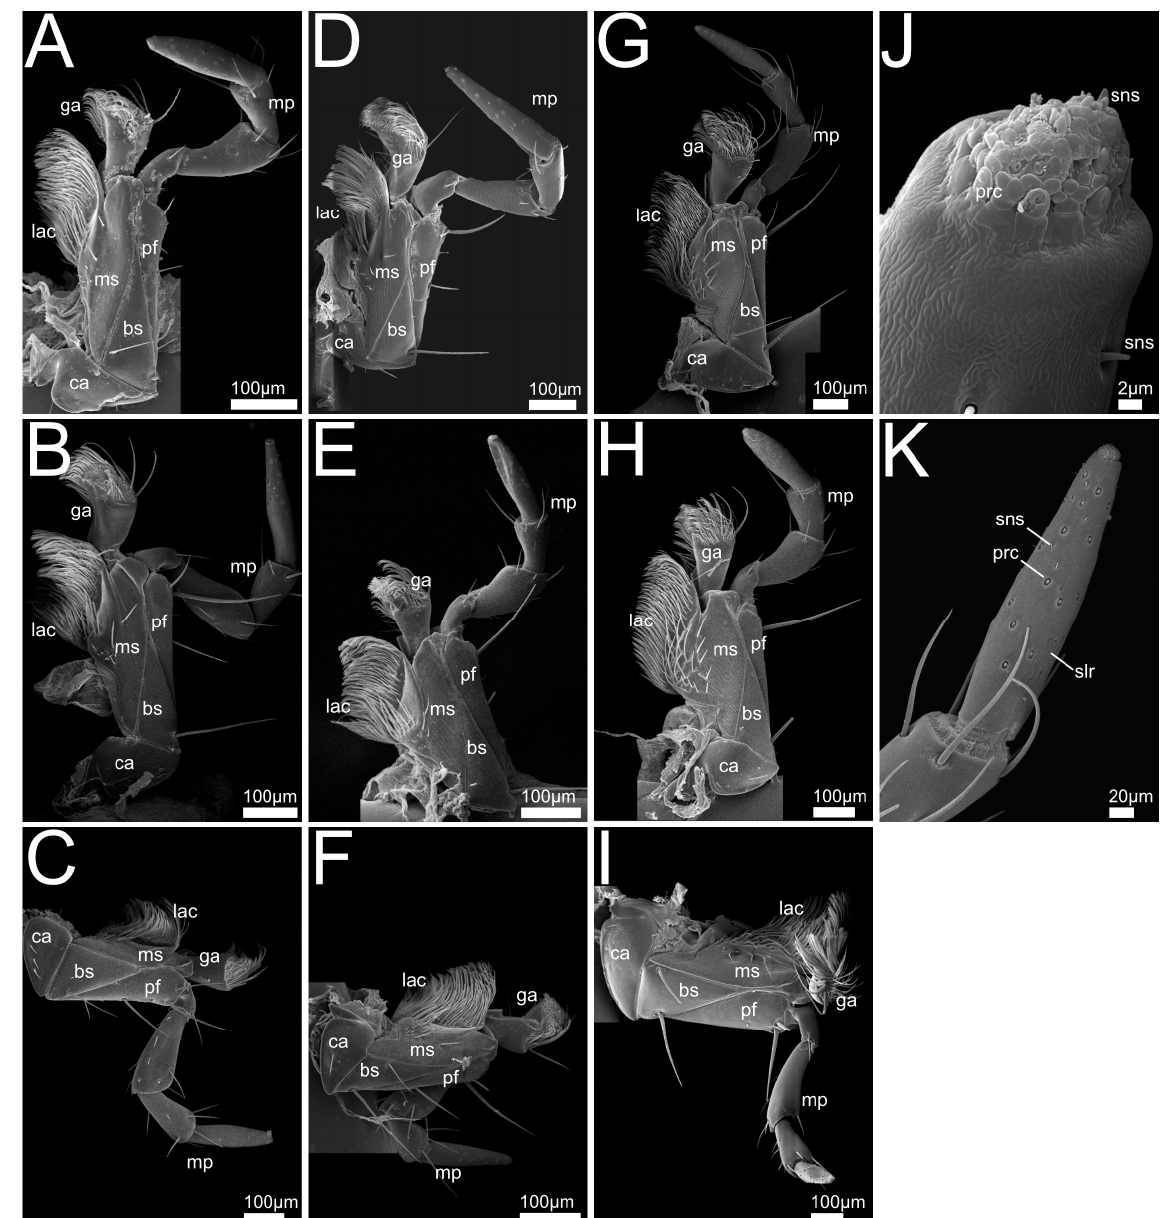
Figure 10. SEM views of Staphylinini maxilla. Images A – I ventral aspect of maxilla J – K with detailed views of apical palpomeres and receptors. ( A ) Bisnius sordidus ; ( B ) Philonthus varians ; ( C ) P. marginatus ; ( D ) P. rufipes ; ( E ) P. discoideus , ( F ) P. alpinus ; ( G ) Quedius cinctus ; ( H ) Q. cruentus ; ( I ) Q. curtipennis ; ( J ) B. sordidus , apical receptor bundle; ( K ) Q. cinctus , apical segment of maxillary palp. Abbreviations: bs: basistipes; ca: cardo; ga: galea; lac: lacinia; ms: mediostipes; mp: maxillary palp; pf: palpifer; prc: papilliform receptor; slr: slit-like receptors; sns: sensilla.